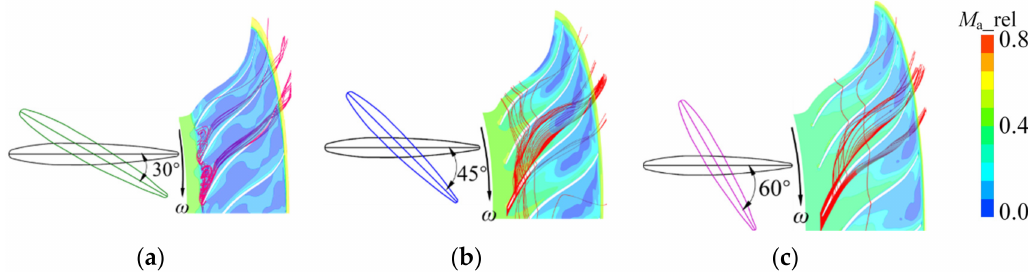
Figure 8. Relative Mach number and streamlines distribution at 97% span ( ϕ = 0.0833): ( a ) IGV30; ( b ) IGV45; ( c ) IGV60.